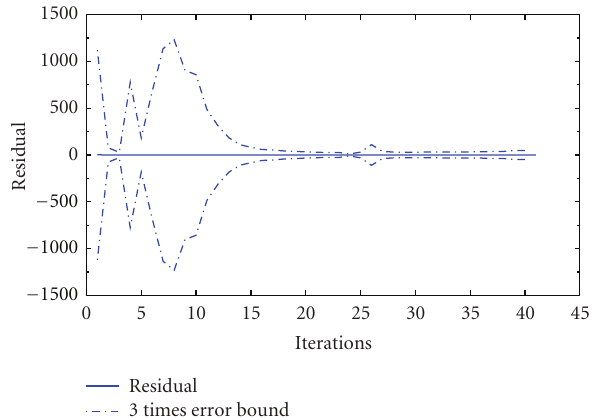
Figure 5: EKF state responses.